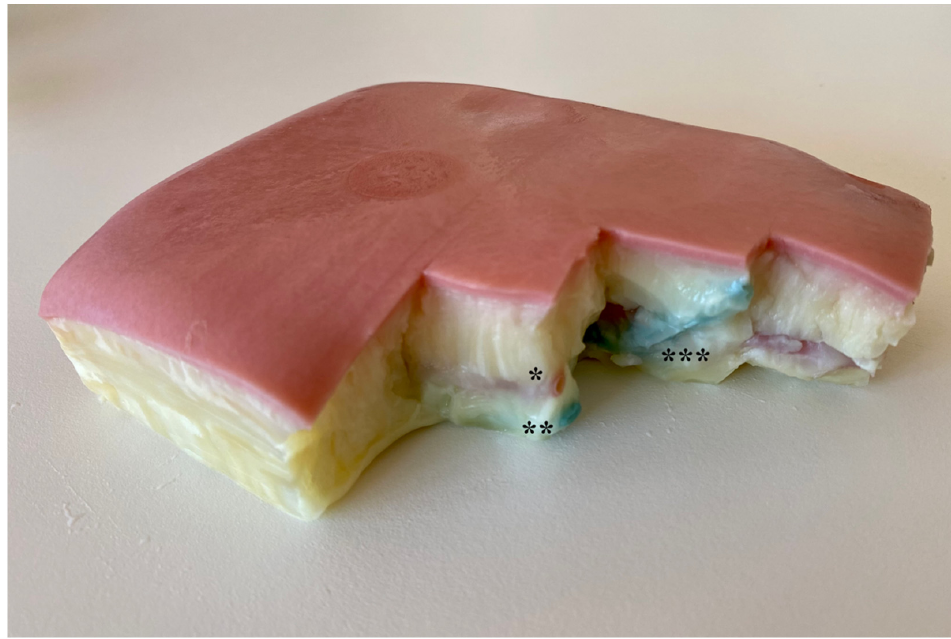
Figure 1. pAVF simulation model inlay. Legend: hydrogel inlay with embedded silicone artery *, vein ** and vessel crossing ***.